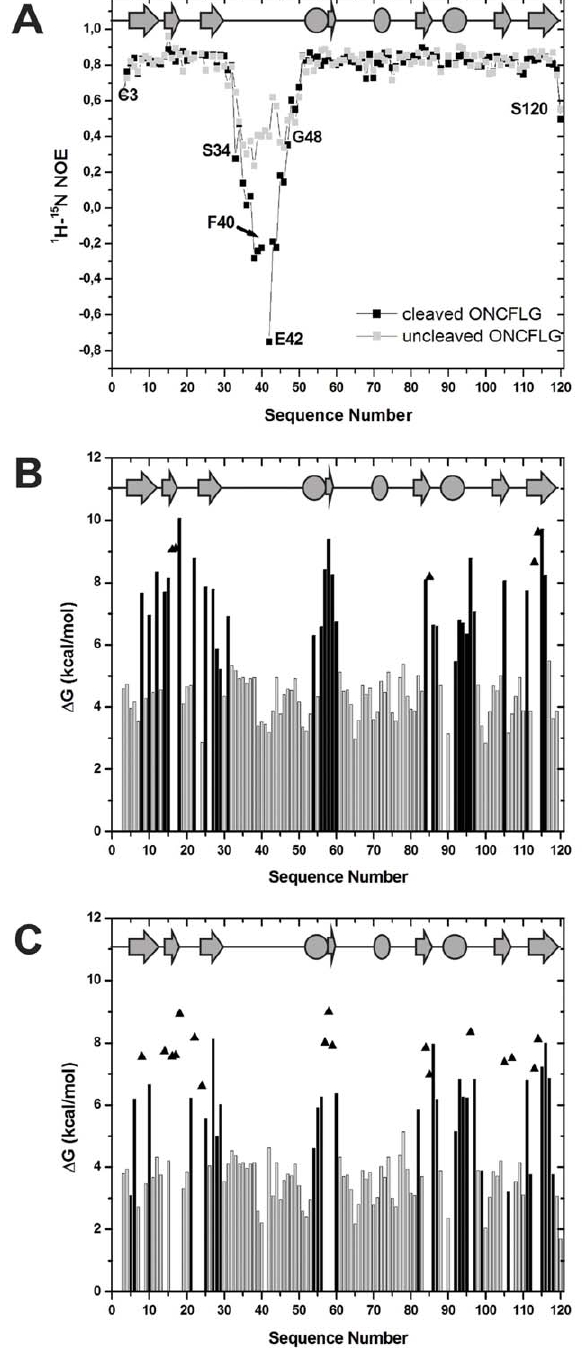
Figure 6. Dynamics and conformational stability of the ONCFLG variant forms. (A) The 1 H- 15 N NOE ratio for the uncleaved (gray) and cleaved ONCFLG forms (black) as a function of the sequence number. Lines connecting gray or black squares boxes are used to guide the eye. (B) and (C) D G HX values obtained by NMR-monitored 1 H- 2 H exchange of the uncleaved (B) and cleaved (C) forms of the ONCFLG as a function of the sequence number. Grey bars represent the upper limits for fast exchanging groups, black bars show experimentally measured values and triangles indicate the estimated lower limit for slow exchanging groups. The secondary structure is represented on the top of each panel, b -strands as gray arrows and a -helices as ovals.